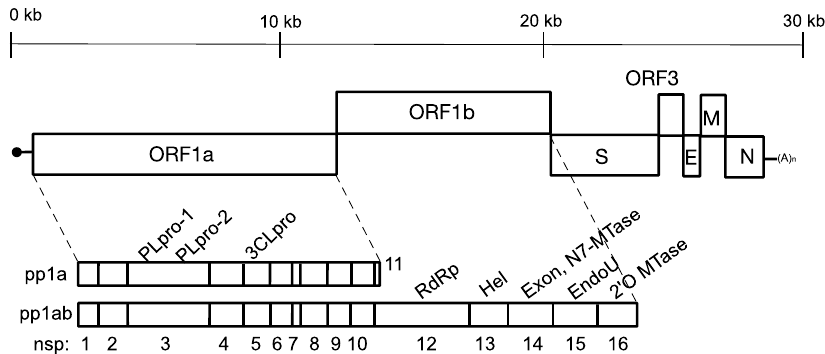
Figure 1. Schematic organization of the porcine epidemic diarrhea virus (PEDV) genome, polypeptides pp1a and pp1ab. The genome encodes open reading frames 1a (ORF1a) and 1b (ORF1b), followed by the genes encoding spike protein (S), accessory protein 3 (ORF3), envelope protein (E), membrane (M) and nucleocapsid (N) proteins. Translation of ORF1a and 1b results in two polypeptides pp1a and pp1ab, mediated by a − 1 frame-shifting signal [5]. The polypeptides are protease-processed into 16 non-structural proteins (nsps). PLpro: Papain-like protease; 3CLpro: 3C-like protease; RdRp: RNA-dependent RNA polymerase; Hel: Helicase; Exon: Exonuclease; MTase: Methyltransferase: EndoU: